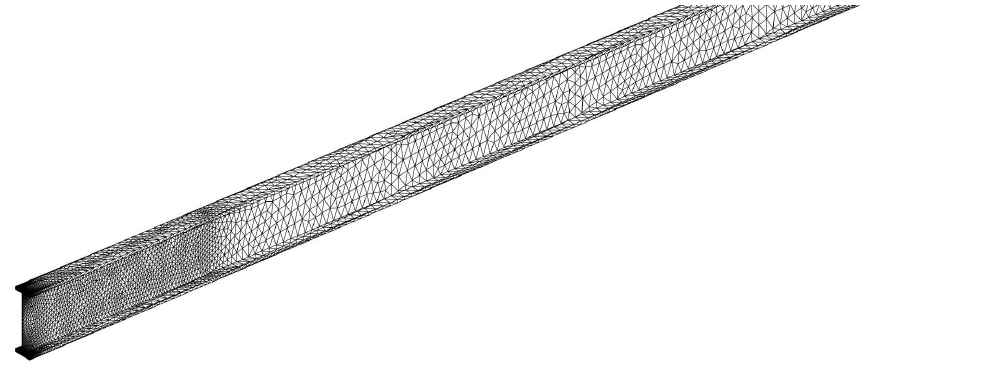
Figure 5. Beam mesh for the